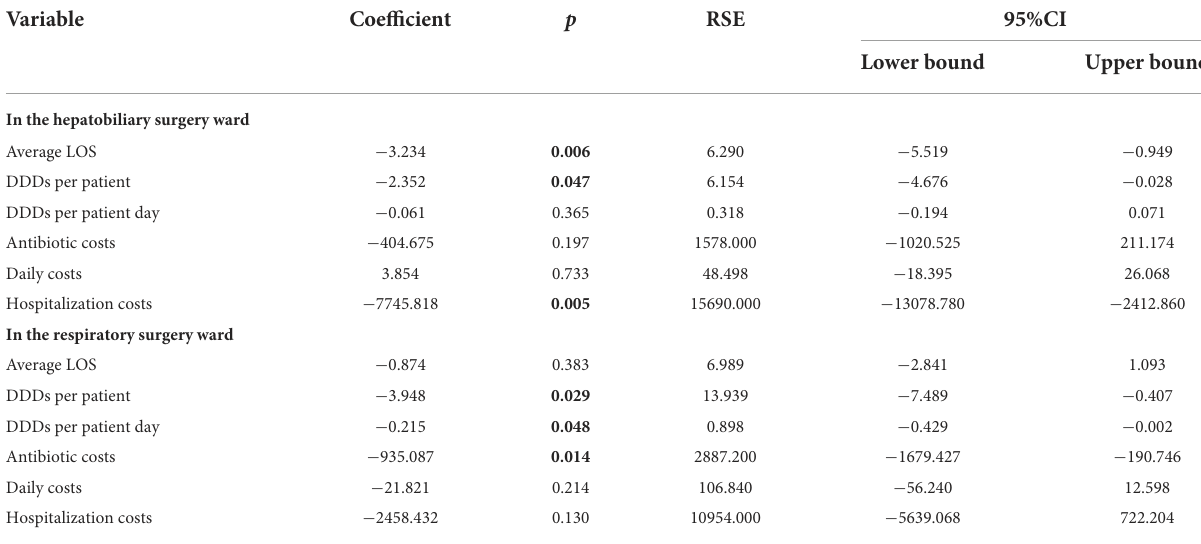
TABLE 4 DID results from liner regression analyses in two wards. Variable